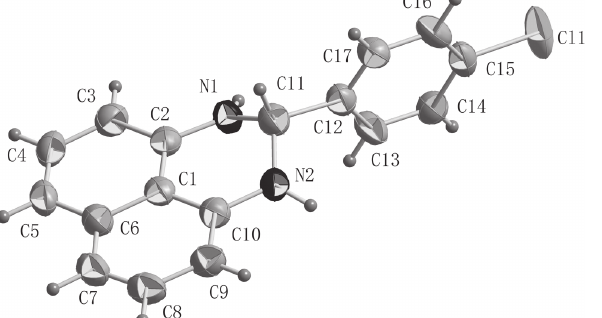
Table 1: Data collection and handling.